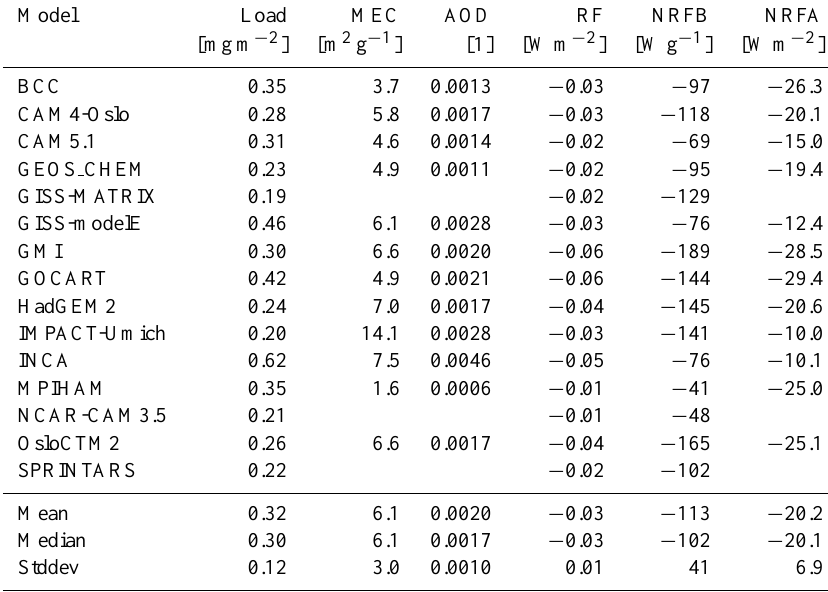
Table 6. Same as Table 4 for OA from FF and BF emissions.